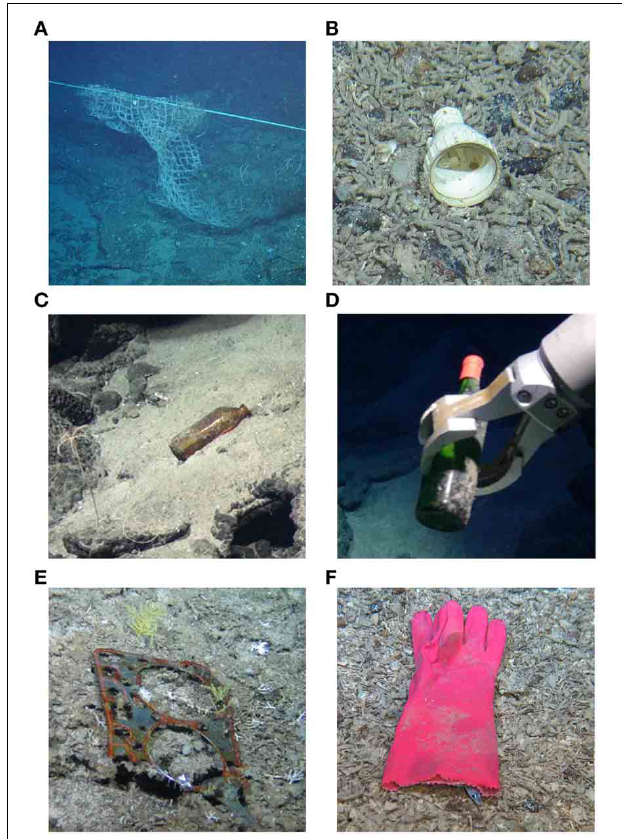
FIGURE 2 | Six examples of benthic litter items observed during surveys in the Atlantic Ocean and Indian Ocean: (A) fishing gear from the Indian Ocean; (B) plastic object, possible plumbing item from the Indian Ocean; (C) glass bottle from the Atlantic Ocean; (D) glass bottle from the Atlantic Ocean; (E) engine head gasket, categorized as “other” from the Indian Ocean (F) work glove, categorized as “other” from the Atlantic